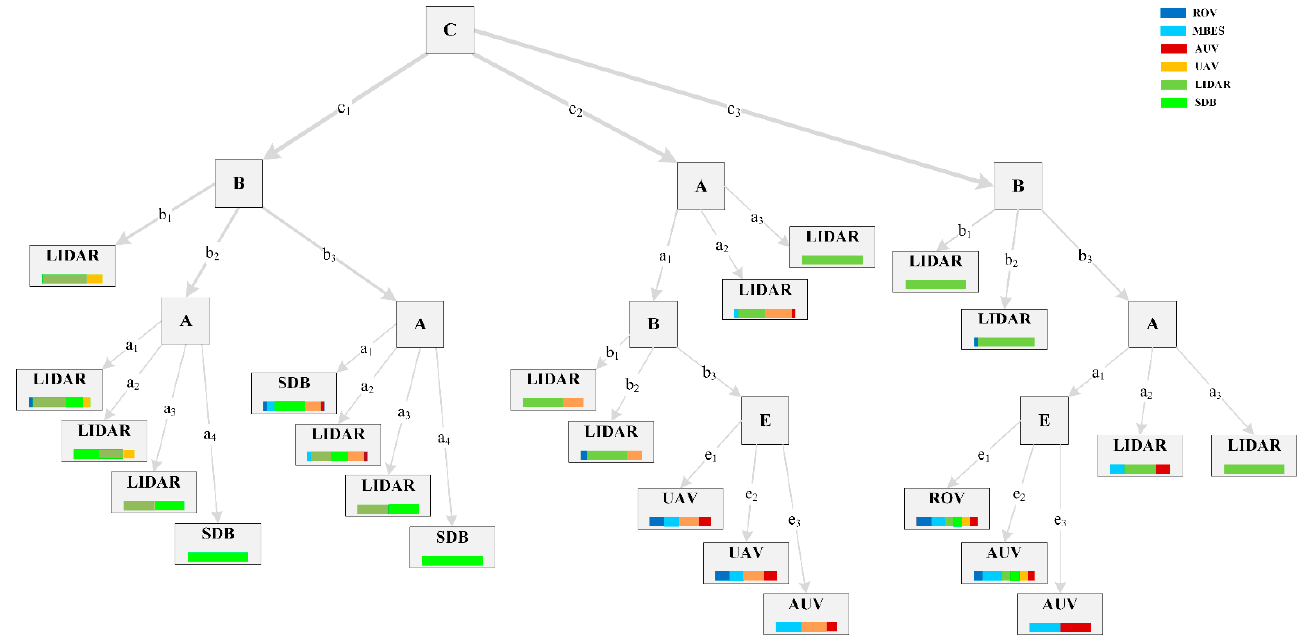
Figure 5. Decision tree using information gain ratio algorithm.